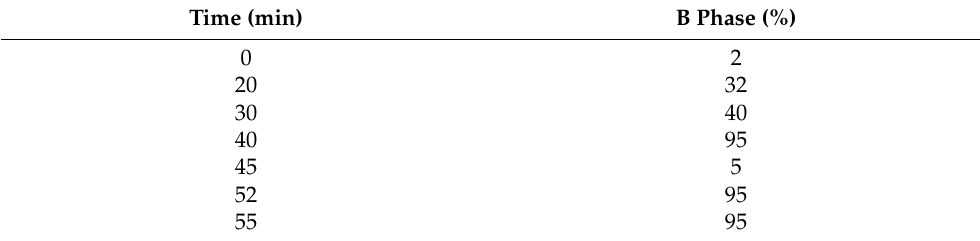
Table 1. Time and gradient (B phase, %) used for the HPLC-DAD analysis of phenolic acids. Time (min) B Phase (%) 0 2 20 32